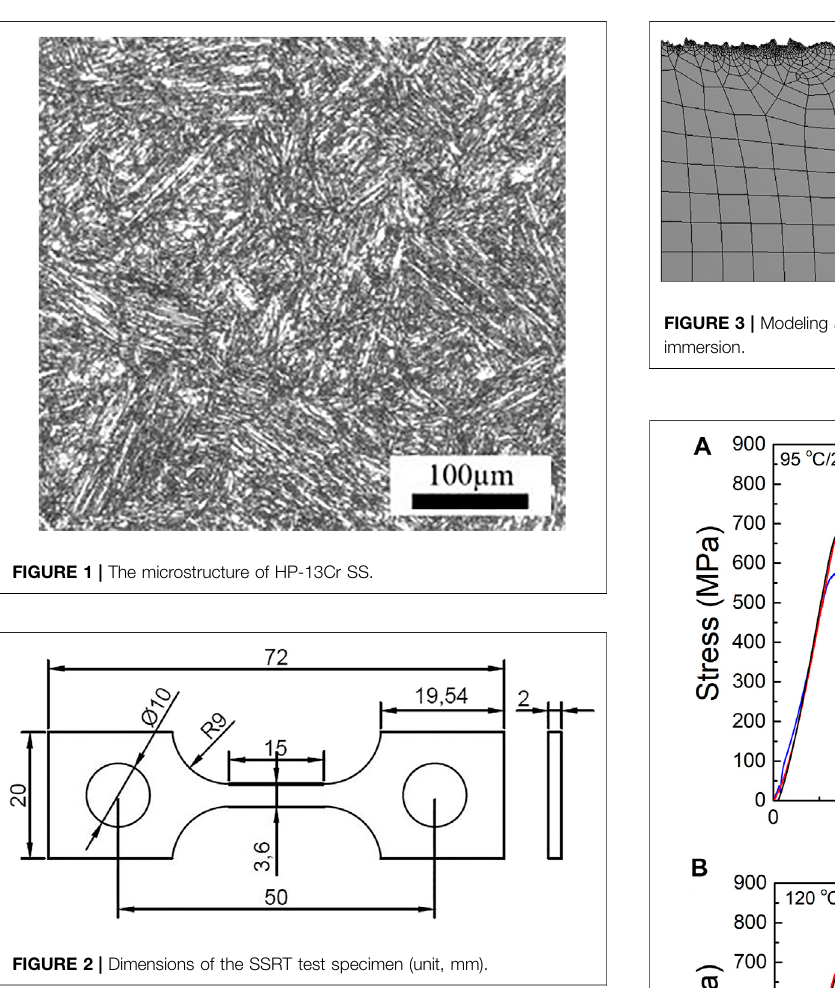
FIGURE 2 | Dimensions of the SSRT test specimen (unit, mm).